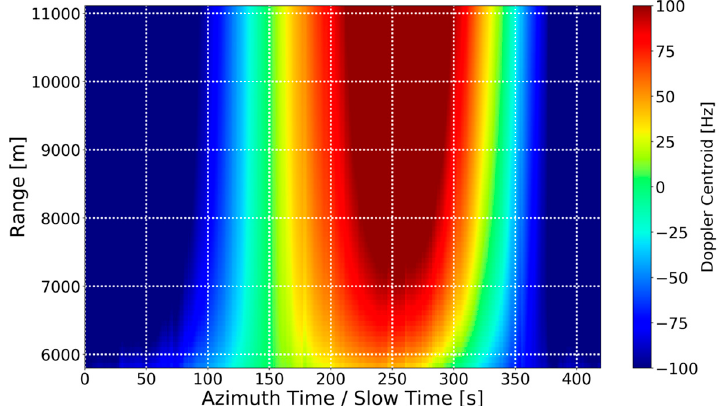
Figure 3. Clutter Doppler centroid map computed by using the measured aircraft Euler angles for a circular flight carried out with F-SAR (details about the flight are given in Section 6).